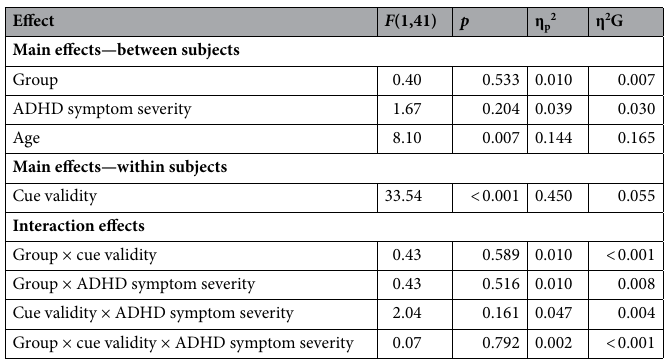
Table 2. The cue validity effect (valid cue vs. invalid cue) and group differences in the cue validity effect on mean reaction time. ADHD: Attention-Deficit/Hyperactivity Disorder.